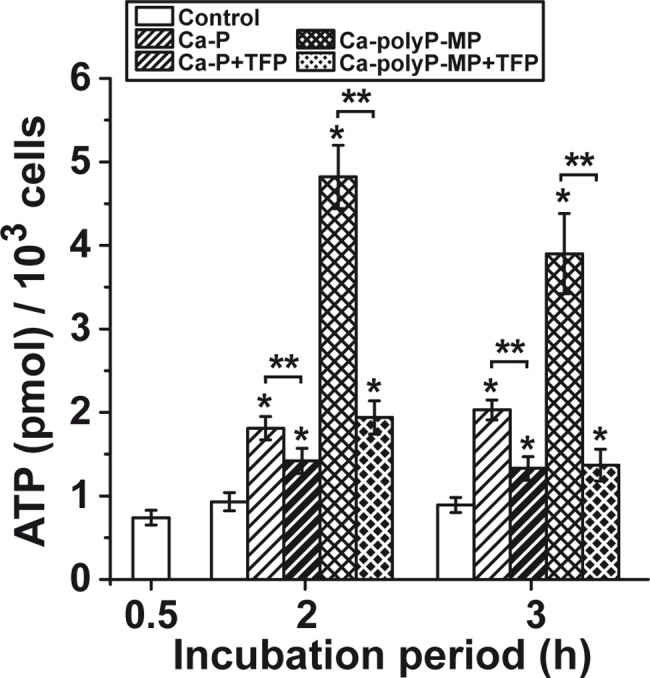
Influence of polyP on the intracellular ATP level.The effects of both “Ca-P particles” [bars hatched to the right] and “Ca-polyP-MP” [cross hatched bars]) are shown; the controls without the polymer were run in parallel [open bars]. The cells were incubated with 30 μg/mL of the particles for up to 3 h; then ATP was extracted and quantitated. In two series of experiments the cells were incubated in addition to phosphate/polyP with 20 μM TFP [bars hatched to the right, white on black; cross hatched bars, white on black]. Significant differences between the control values (minus phosphate/polyP) and the phosphate/polyP test samples are indicated (* p < 0.05). In addition, the significance between the controls is indicated (** p < 0.05).